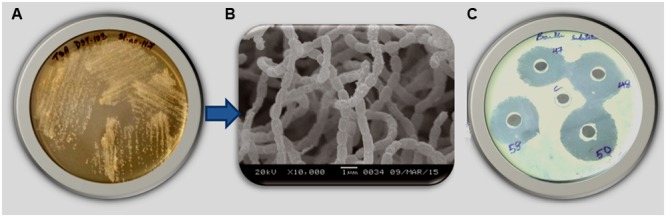
(A) Morphological appearance of Strain DST103 on TSA medium after three weeks of incubation; (B) field emission gun- scanning electron microscope (FEG-SEM) analysis showing spore chain morphology of Strain DST103; (C) Antibacterial activity of Strain DST103 against bacterial pathogen Bacillus subtilis.